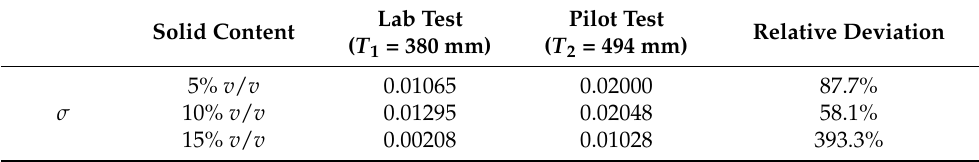
Table 6. The solid uniformity σ before and after scaling up based on the same Reynolds number.